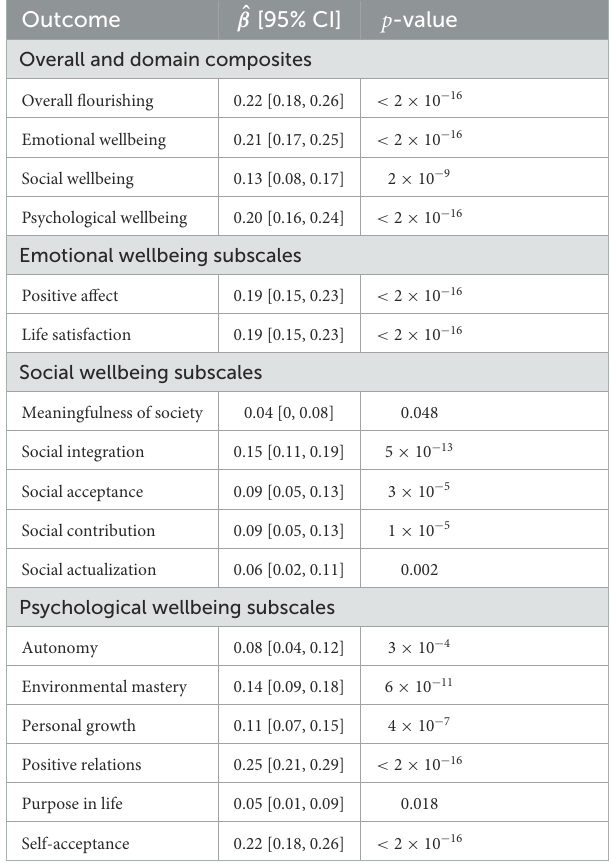
TABLE 3 OLS estimate ( ˆ β ) characterizing association of a 1-SD increase in parental warmth with each of 17 standardized flourishing outcomes, adjusting for all covariates in Supplementary Table